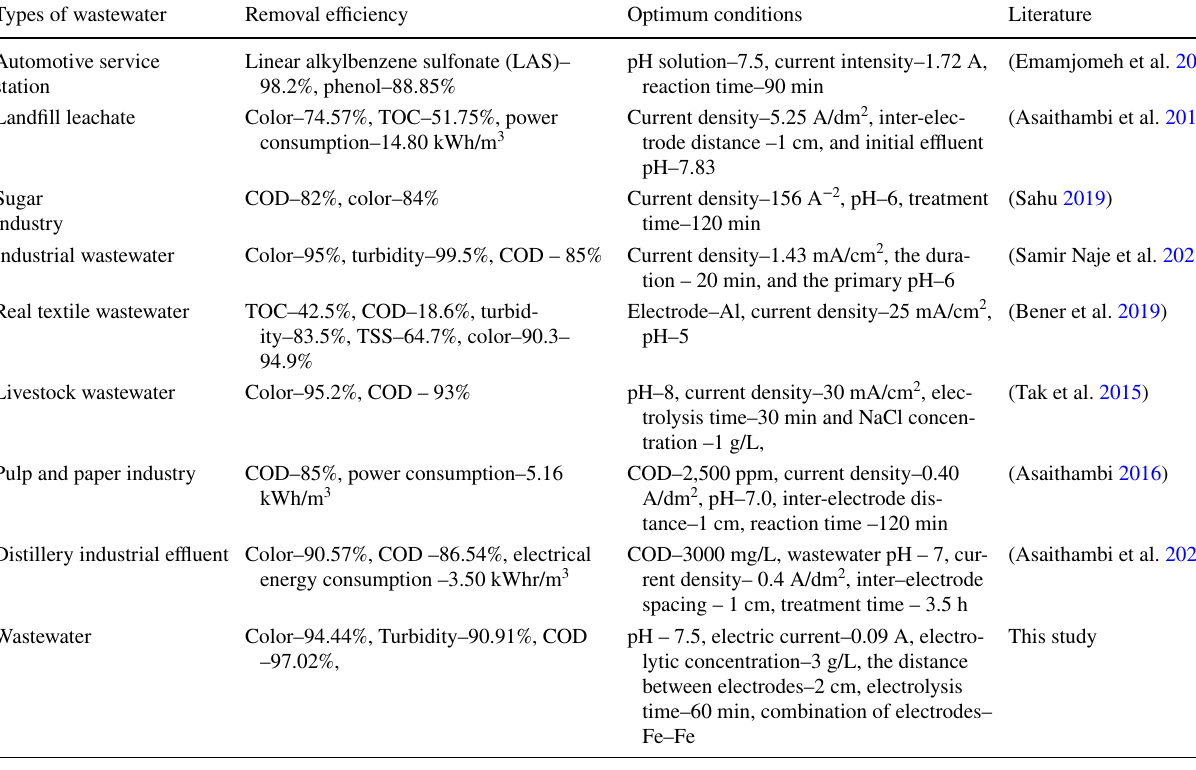
Table. 1 Comparisons of removal efficiencies of different types of wastewater by using electrocoagulation technology